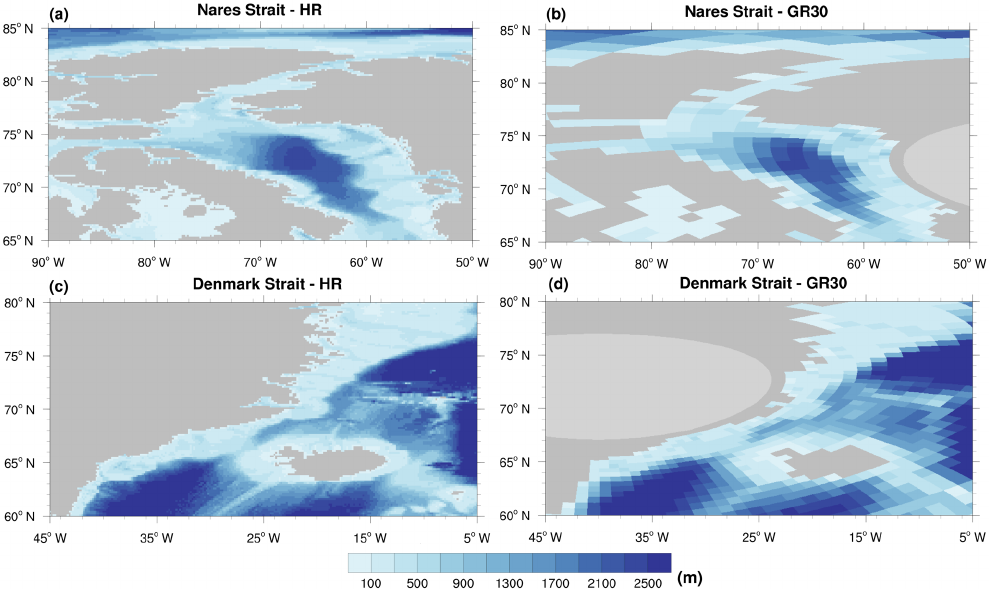
Figure 3. Detailed present-day ocean bathymetry (m) and land-sea mask for the Nares Strait (a) HR and (b) GR30; and the Denmark Strait (c) HR and (d)